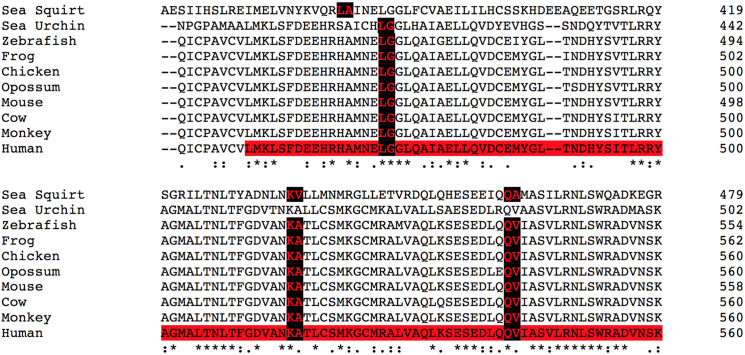
Excerpt of the curated APC alignment generated from the MSA program Clustal Omega.Exon boundaries are labeled in red with a black background. The red highlighted region in the human sequence corresponds to a portion of an Armadillo Repeat domain.